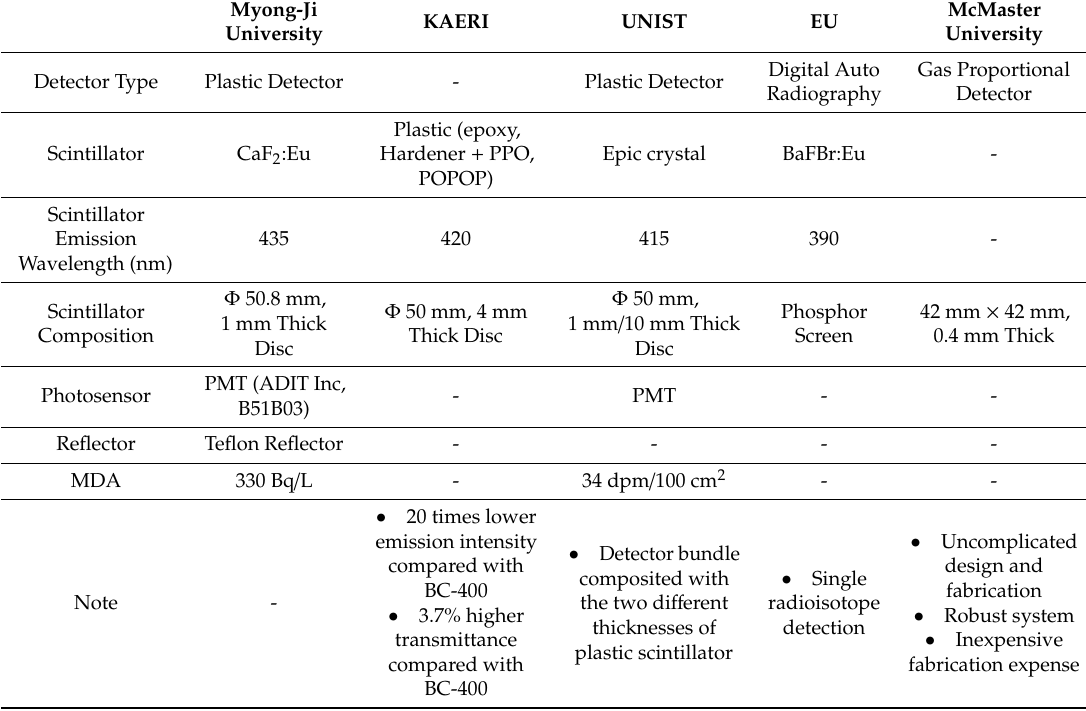
Table 20. Scintillation detector and proportional